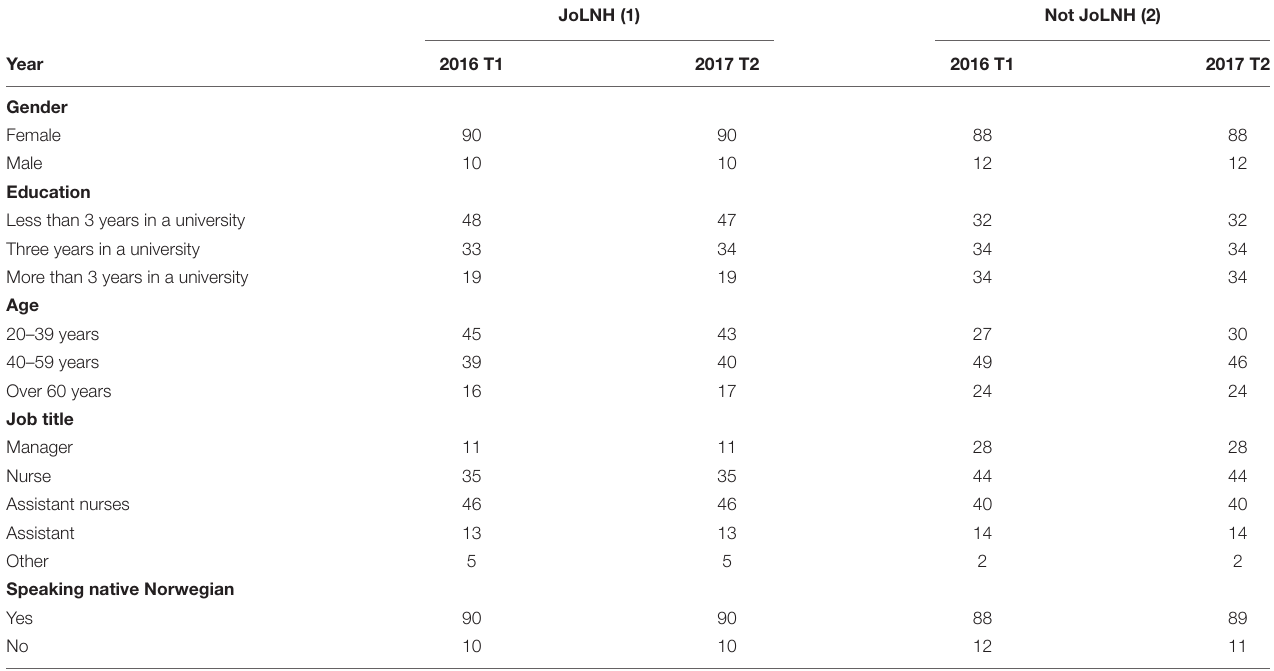
TABLE 2 | Demographic data in the experimental municipality and the control municipality (given in %) in two different waves (T1 and T2). JoLNH